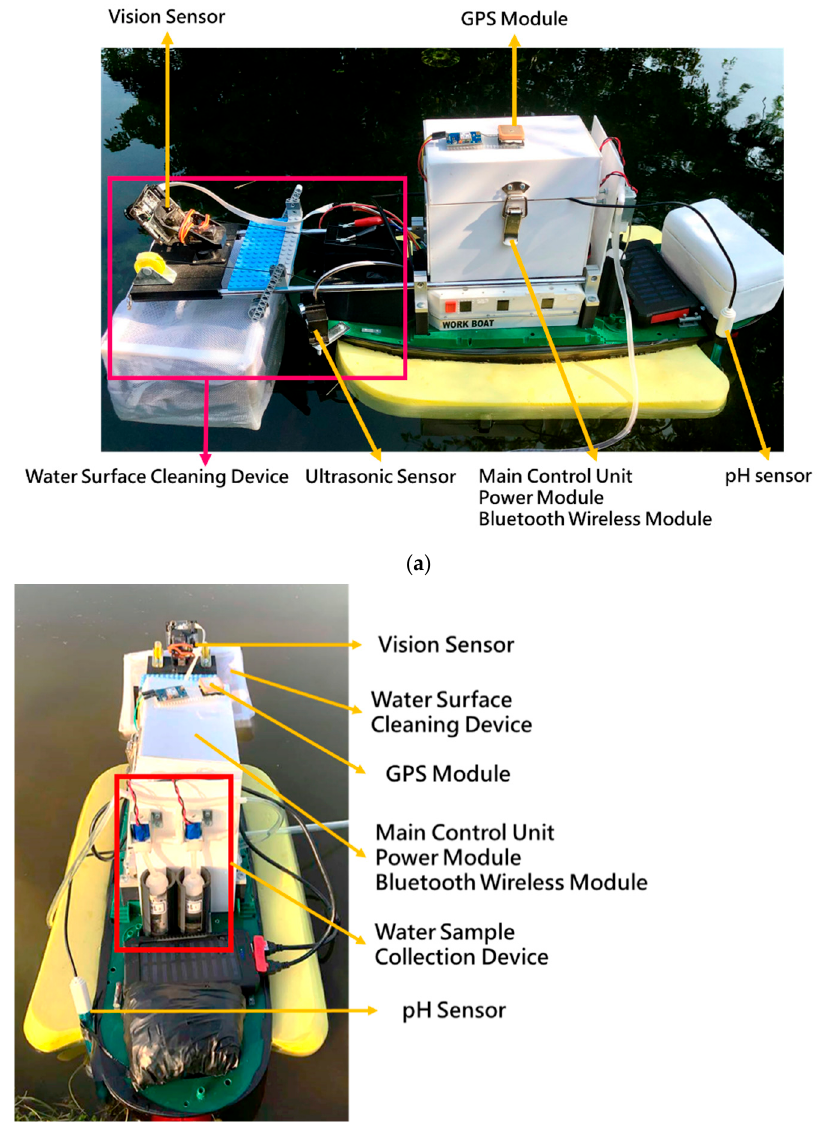
Figure 15. View of the MF-USV. ( a ) Side view. ( b ) Rear view.